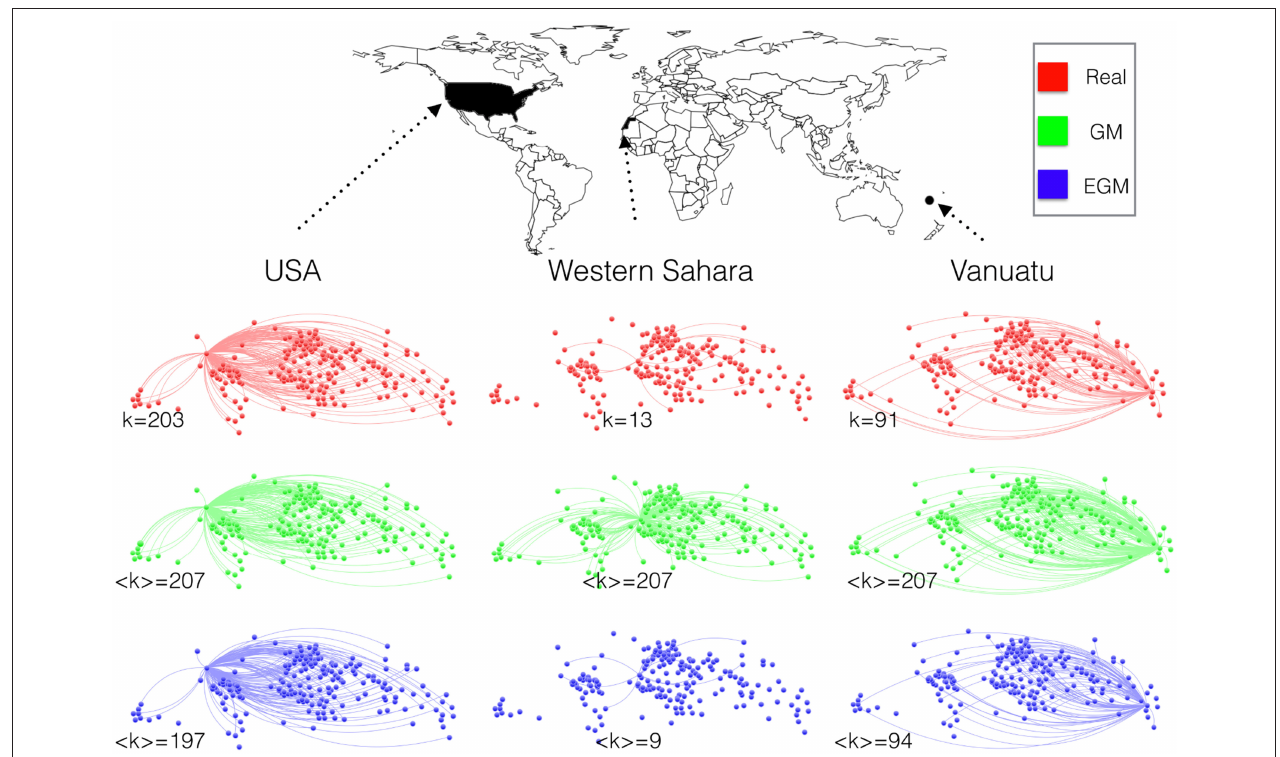
FIGURE 4 | Country-based network configurations for year 2011 in the real ITN (red), the GM (green), and the EGM (blue). For three representative countries, we show the connections to all trade partners in the world. The total number of countries in the data (see Appendix ) is N = 208. The three countries are selected on the basis of their empirical degree k : the country with maximum degree (USA, k = 203), the one with minimum degree (Western Sahara, k = 13), and one with intermediate degree (Vanuatu, k = 91). The GM produces always the maximum possible number ( N − 1) of connections. By contrast, the EGM produces connections randomly with probability p ij , so links change from realization to realization. The expected degree is however independent of the individual realizations and is close to the empirical one for all countries. We have selected a typical realization that produces a degree equal to the expected degree for each of the three